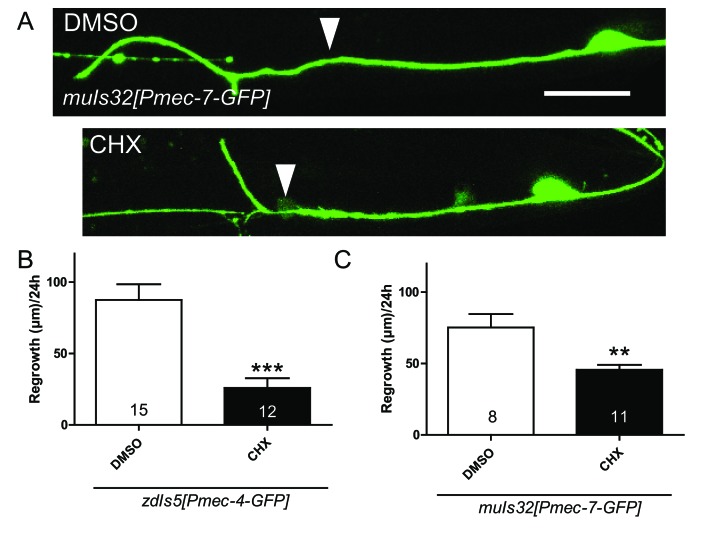
Translation inhibitor prevents axon regrowth.(A) Representative images showing the axon regrowth 24 hr after axotomy with a translation inhibitor, cycloheximide (CHX), or with DMSO as a negative control. Arrowheads indicate the cutting sites. Scale bar: 20 µm. (B and C) Quantification of total axon regrowth 24 hr after axotomy using two different GFP markers, zdIs5 and muIs32. Numbers of worms are indicated. Statistics: Student’s t-test, **p<0.01, ***p<0.001.